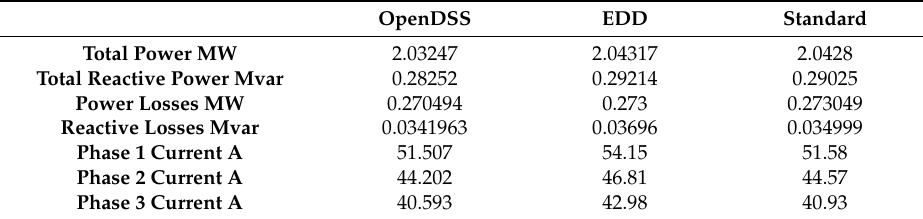
Table 1. IEEE34bus Model Steady State Data